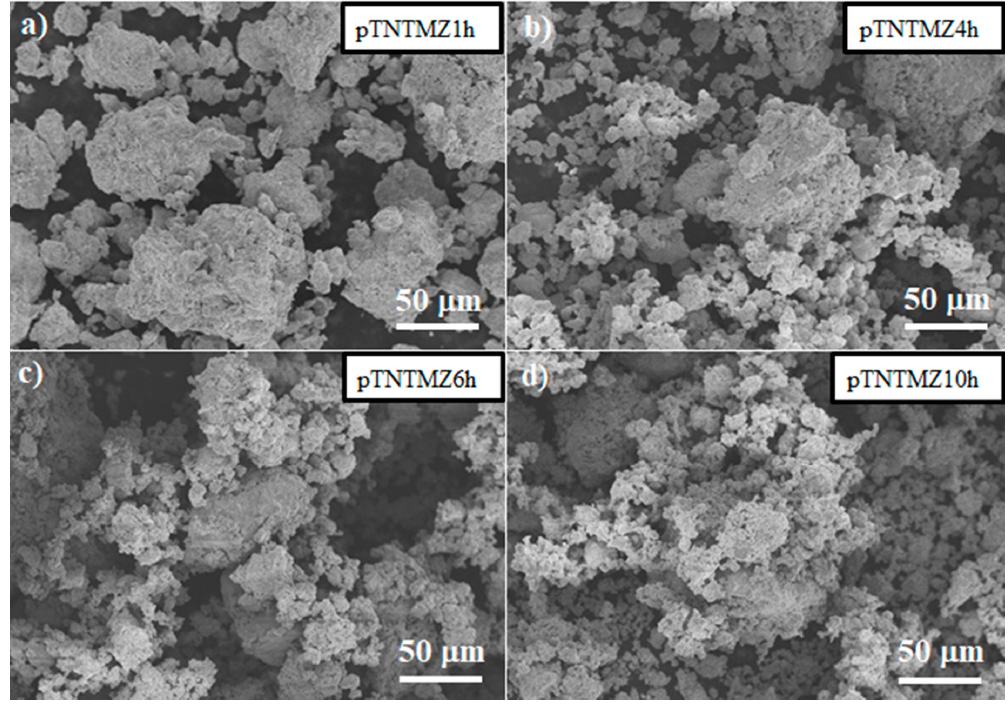
Figure 3. SEM images for ( a ) pTNTMZ1h, ( b ) pTNTMZ4h, ( c ) pTNTMZ6h and ( d ) pTNTMZ10h showing the evolution of the morphology and size of particles with the milling time.